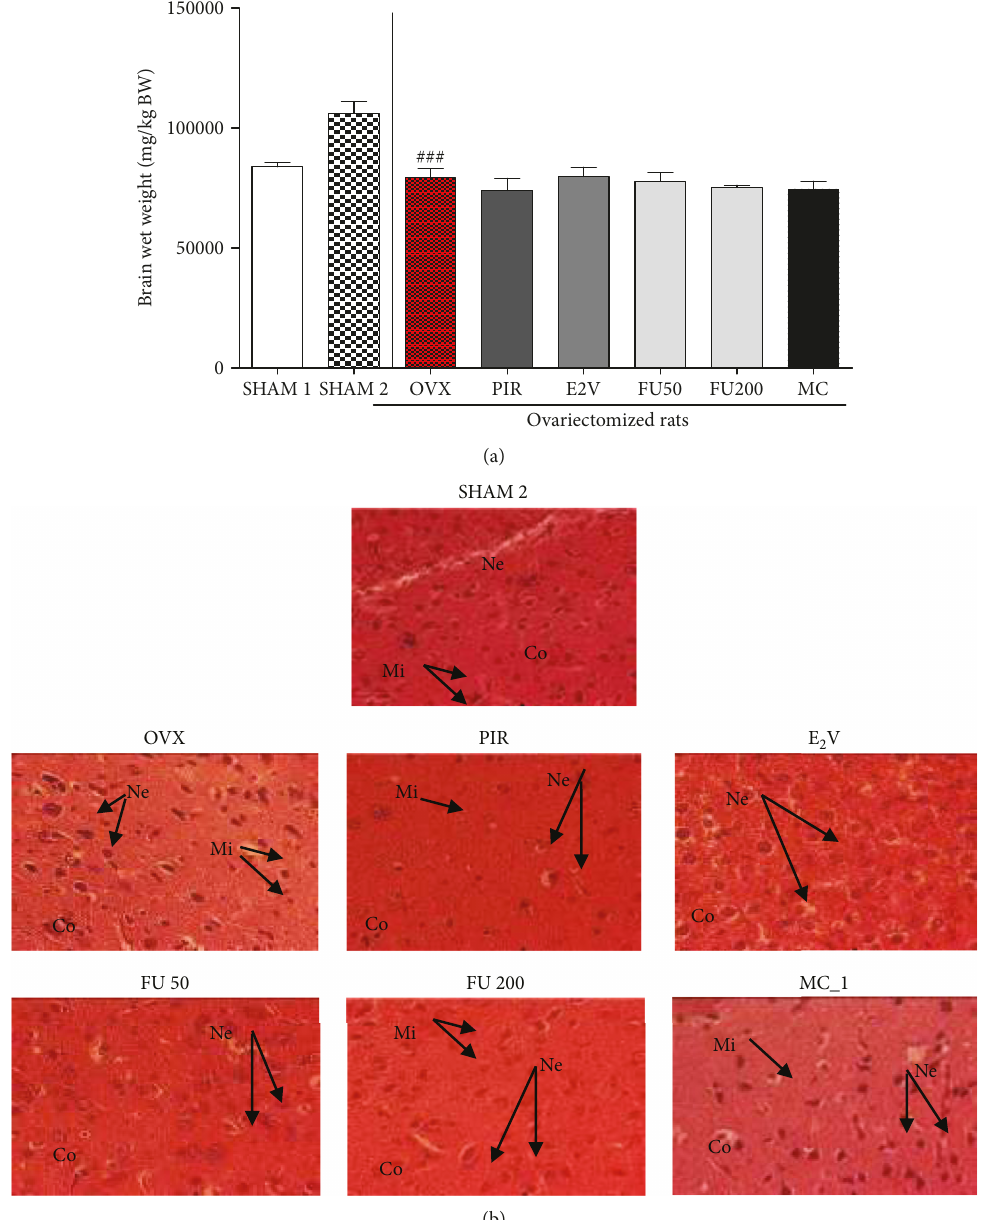
Figure 7: Graphical representation of brain wet weight (a) and microphotographs of HE-stained sections (400x) of the hippocampal region of the brain (b) from di ff erent experimental rat groups in postmenopause-like conditions after 3 weeks of treatment. SHAM 1=sham- operated rats treated with vehicle as normal control 1; SHAM 2=sham-operated rats treated with vehicle as normal control 2; OVX =ovariectomized rats treated with vehicle as negative control; PIR=ovariectomized rats treated with piracetam at the dose of 1.5mg/kg BW as positive control 1; E2V=ovariectomized rats treated with estradiol valerate at the dose of dose 1 mg/kg BW as positive control 2; FU 50 and 200=ovariectomized rats treated with F. umbellata aqueous extract at the doses of 50 and 200 mg/kg BW, respectively; MC=ovariectomized rats treated with 7-methoxycoumarin at the dose of 1 mg/kg BW. Mi=microglia; Ne =neurons; Co =cortex. ### p < 0 001 as compared to SHAM 2